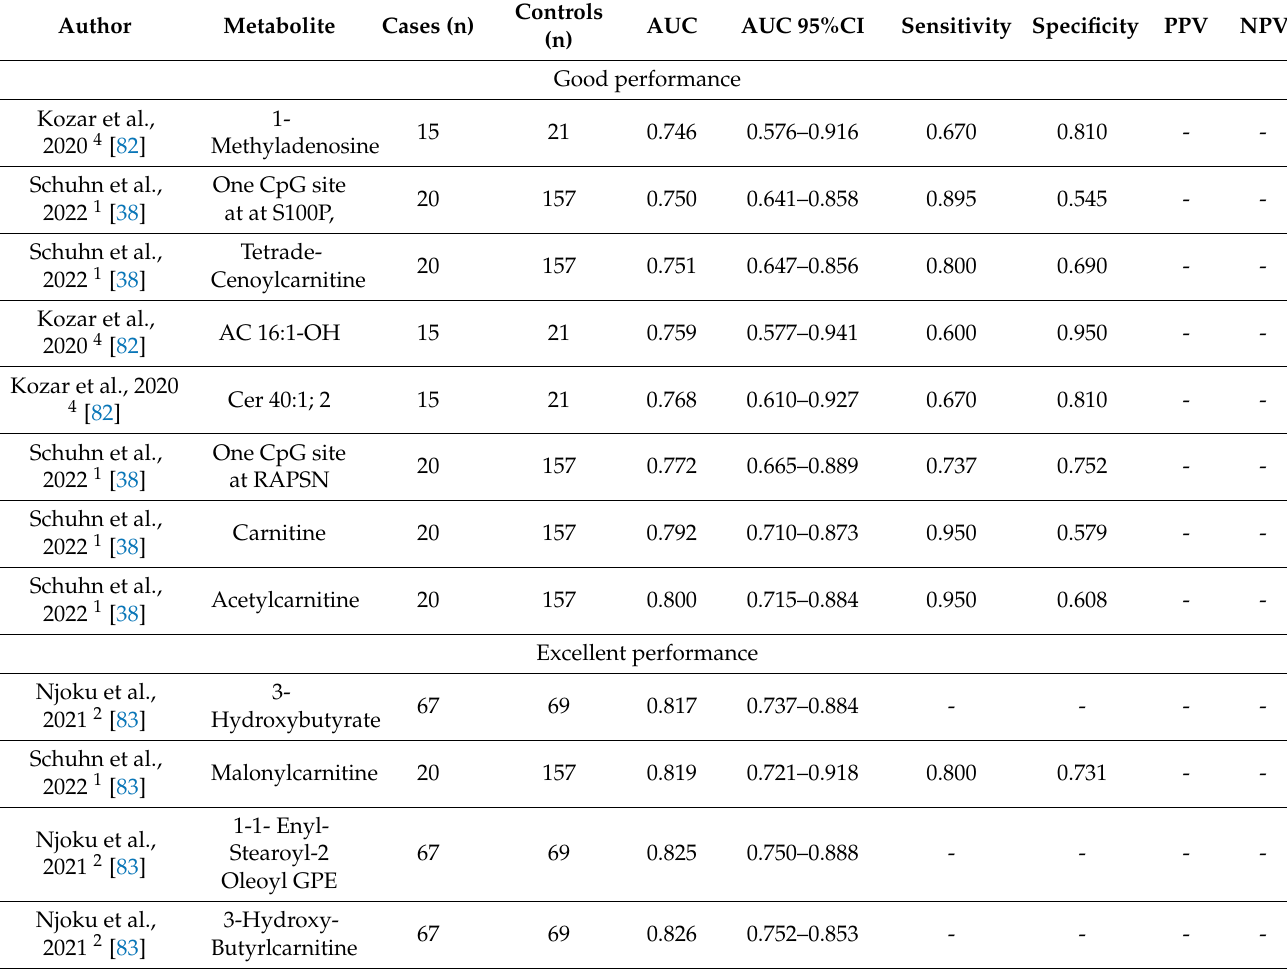
Table 16. Summary table of the performance of metabolites not eligible for inclusion in